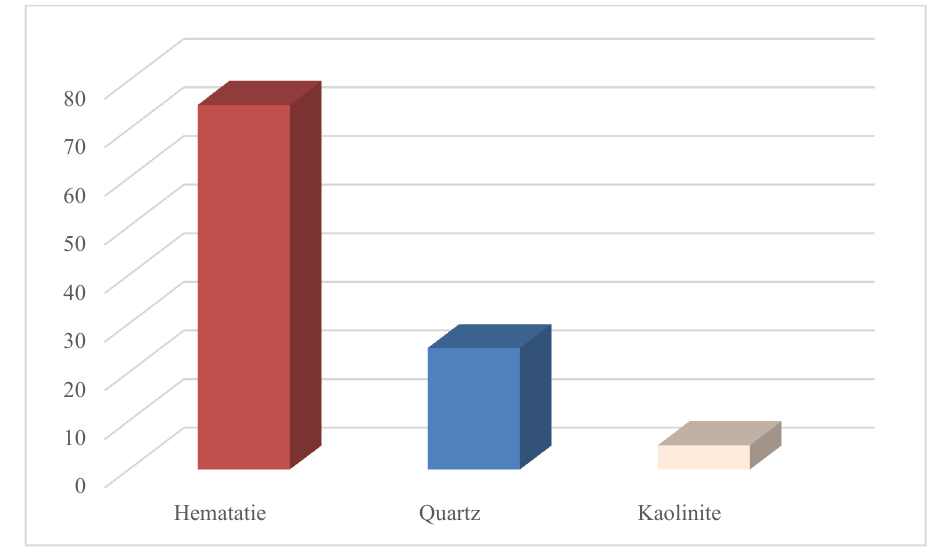
Figure 3. Mineral composition (in%) of the iron ore slime sample.